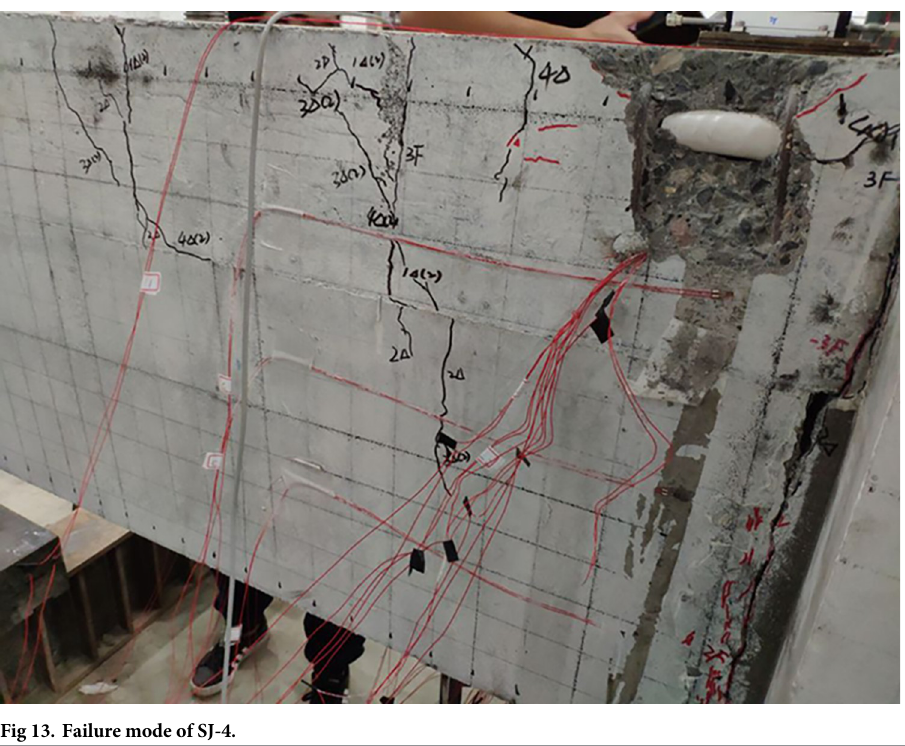
Fig 13. Failure mode of SJ-4.